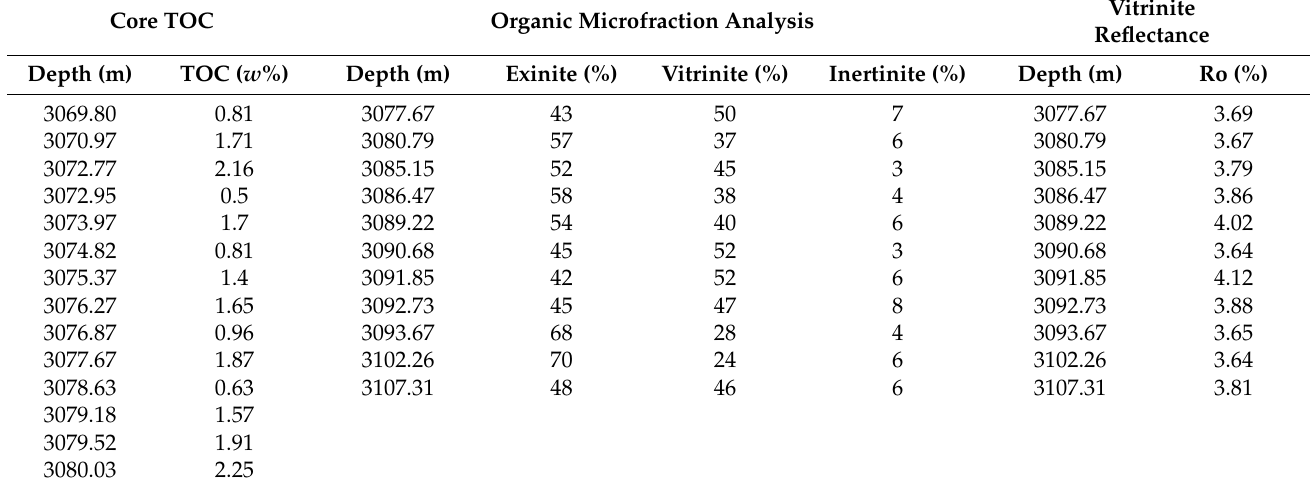
Table 2. Core experimental data of well